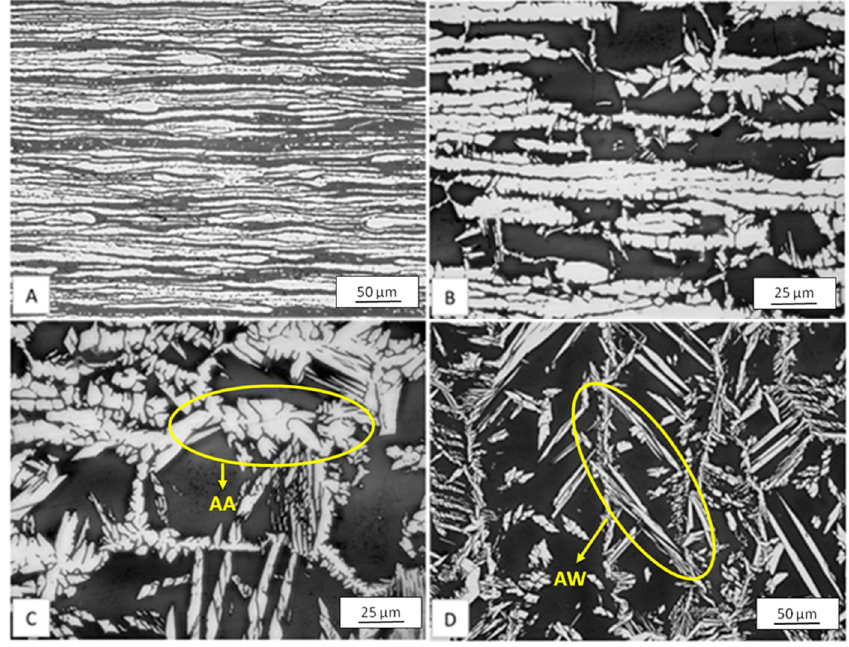
Figure 7. SAF 2507—High heat input: ( A): BM; ( B): LT-HAZ; ( C ): HT-HAZ; ( D ): WM; Beraha Etching. Where: ferrite—dark/dark brown, austenite—light brown, WA—Widmanstätten Austenite, AA—Allotriomorphic Austenite.